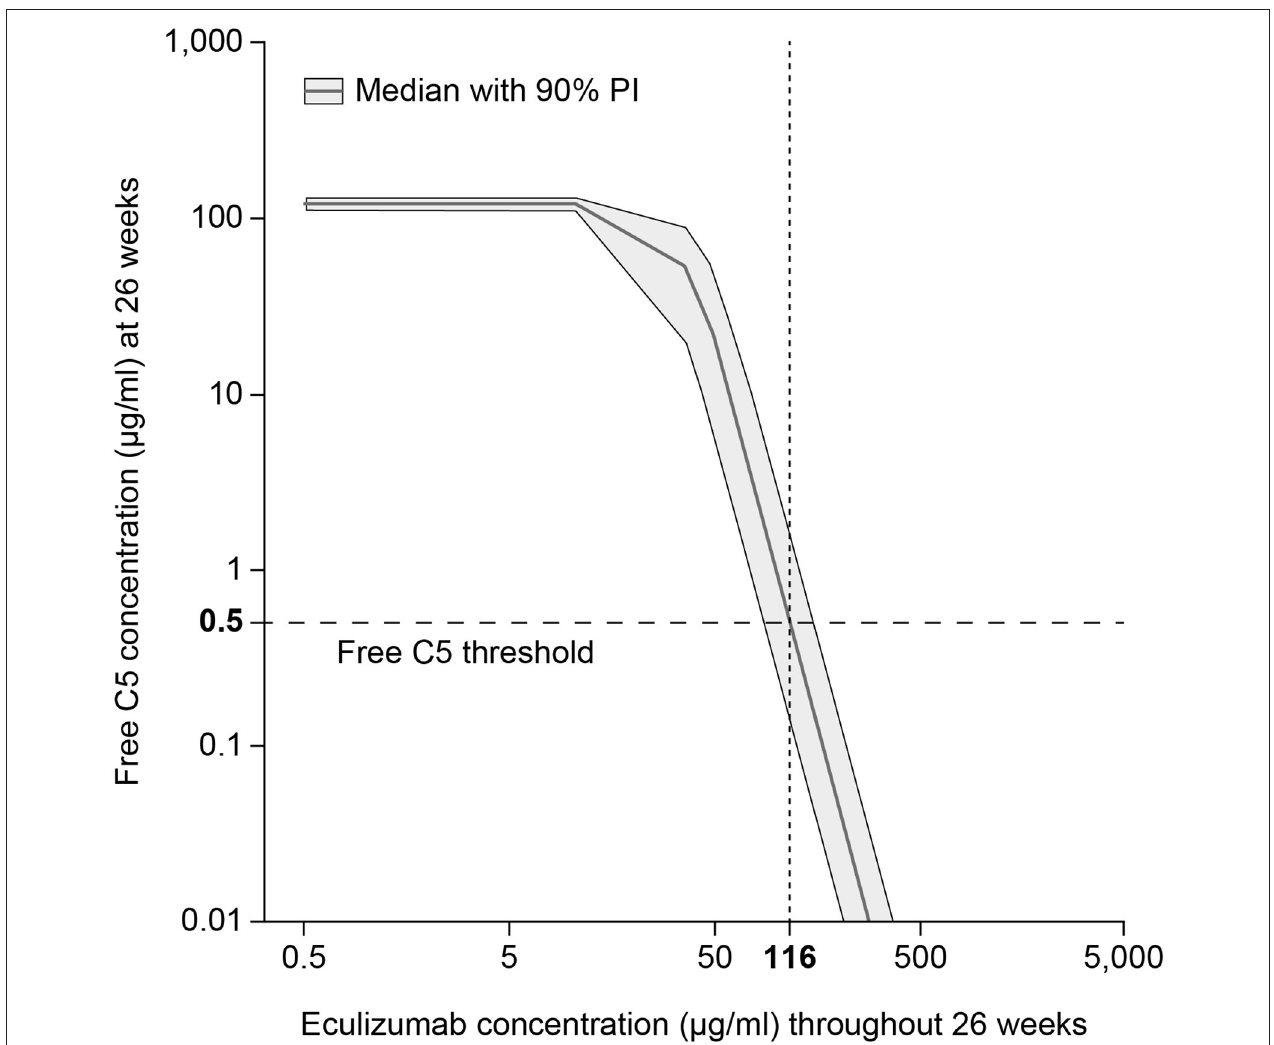
FIGURE 3 | Target eculizumab concentration threshold providing complete complement inhibition (serum free C5 ≤ 0.5 µ g/ml). Simulated exposure–response profile of free C5 concentration vs. eculizumab concentration, summarized using median response (gray solid line) and showing the 90% PI (gray shading). Using the threshold value 0.5 µ g/ml, which is predicted to produce 20% hemolysis, the target concentration of eculizumab was identified as 116 µ g/ml. C5, complement protein 5; PI, prediction